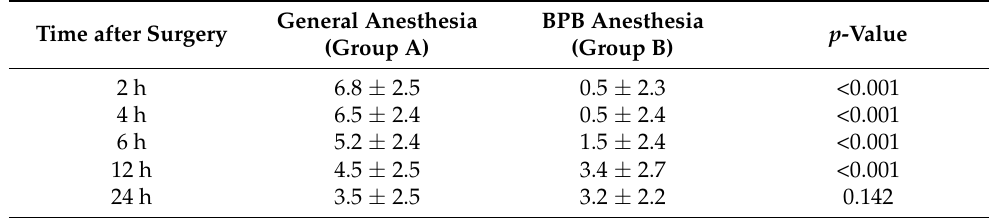
Table 2. Visual analog scale (VAS) scores in both groups at different times after surgery.